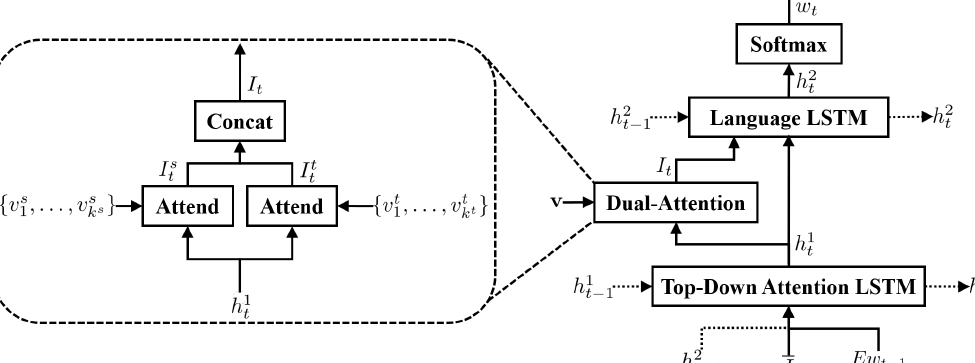
Figure 3. Overview of our framework and the Dual-Attention Module used for handling the panoptic segmentation features. The features of the things and stuff classes are fed into the pathway to perform attention individually. The attended features are then concatenated and fed into the LSTM to generate